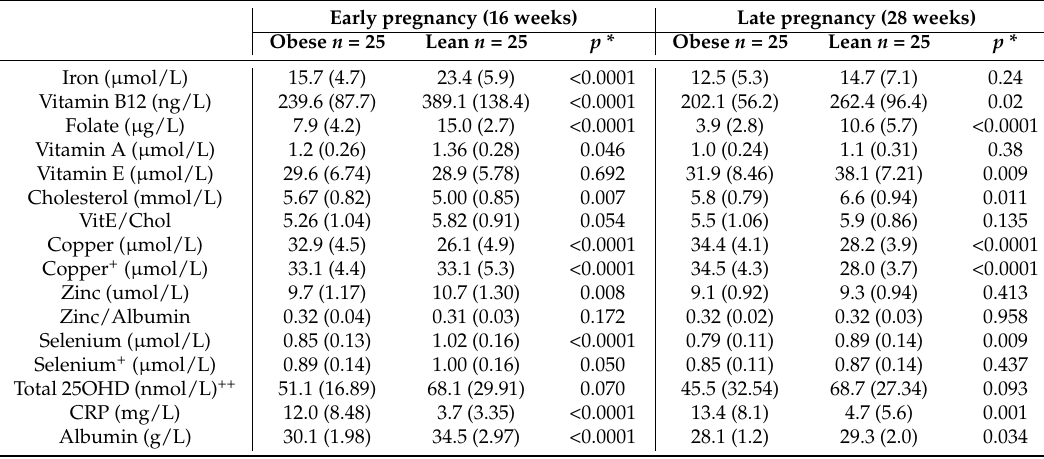
Table 3. Serum levels of essential micronutrients in early and late pregnancy.